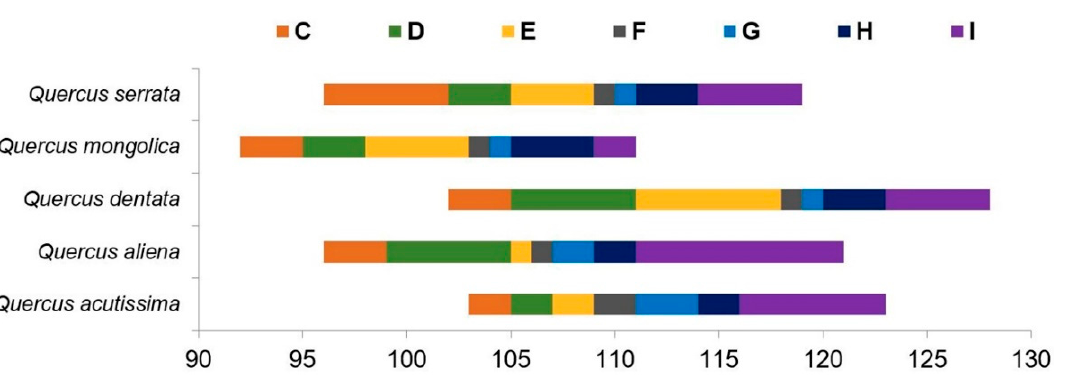
Figure 3. Lengths of flowering stages in oak species ( Quercus acutissima ; Quercus aliena ; Quercus dentata ; Quercus mongolica ; Quercus serrata ). Abbreviations: (C) catkin development; (D) catkin elongation; (E) maturation of catkin; (F) start of flowering; (G) full flowering; (H) senescence; (I) catkin fall.